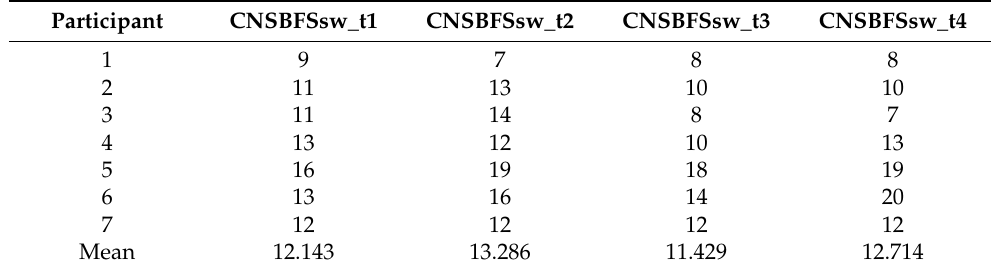
Table 19. CNS-BFS swallowing subscore (points) individual and mean measurements at four assess- ment time